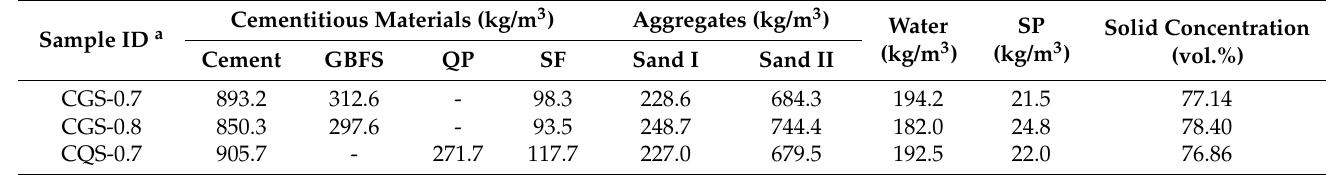
Table 4. Mixture proportions of solid particle mixtures and the solid concentration of the UHPC matrices.